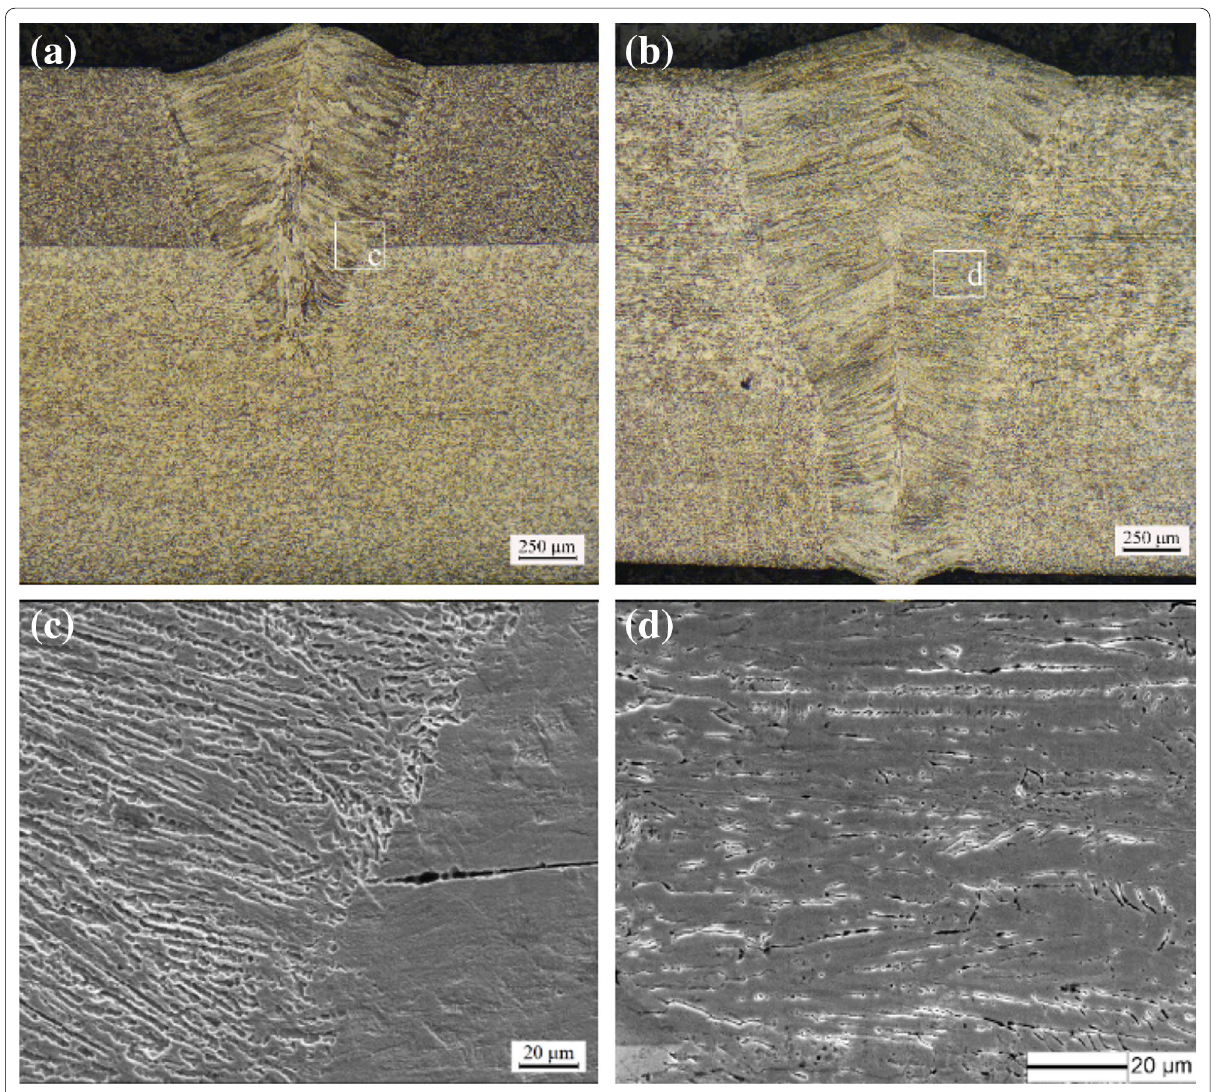
Figure 2 Micrographs of laser welded lap joints: a overall view of 0.8 and HAZ of 0.8 1.5-N near lap interface, d microstructure of 1.5 +